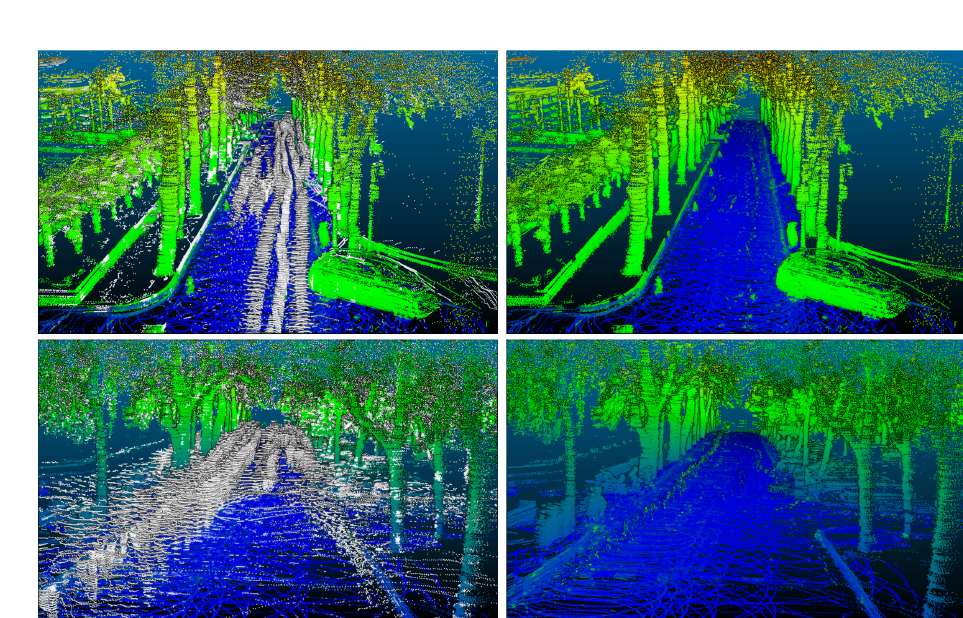
Figure 9. Detailed outdoor mapping results of playground. The point cloud is rendered by height and white points are with less confidence value than the